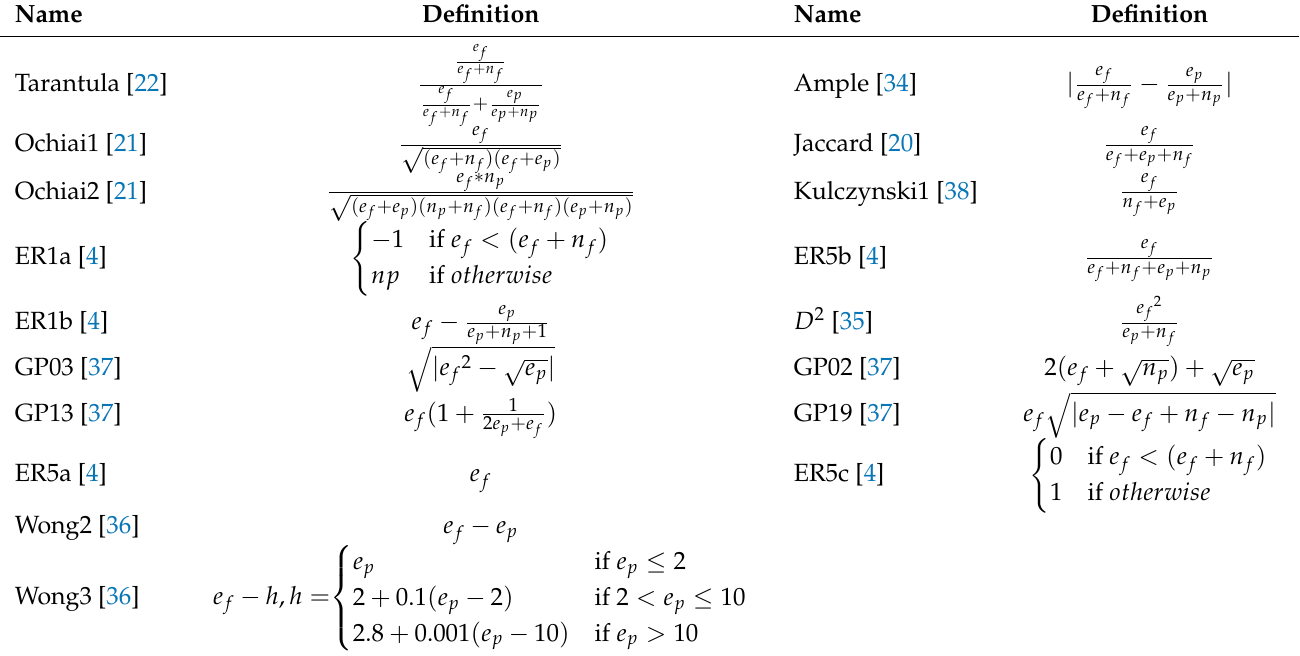
Table 1. Some notable well-performing